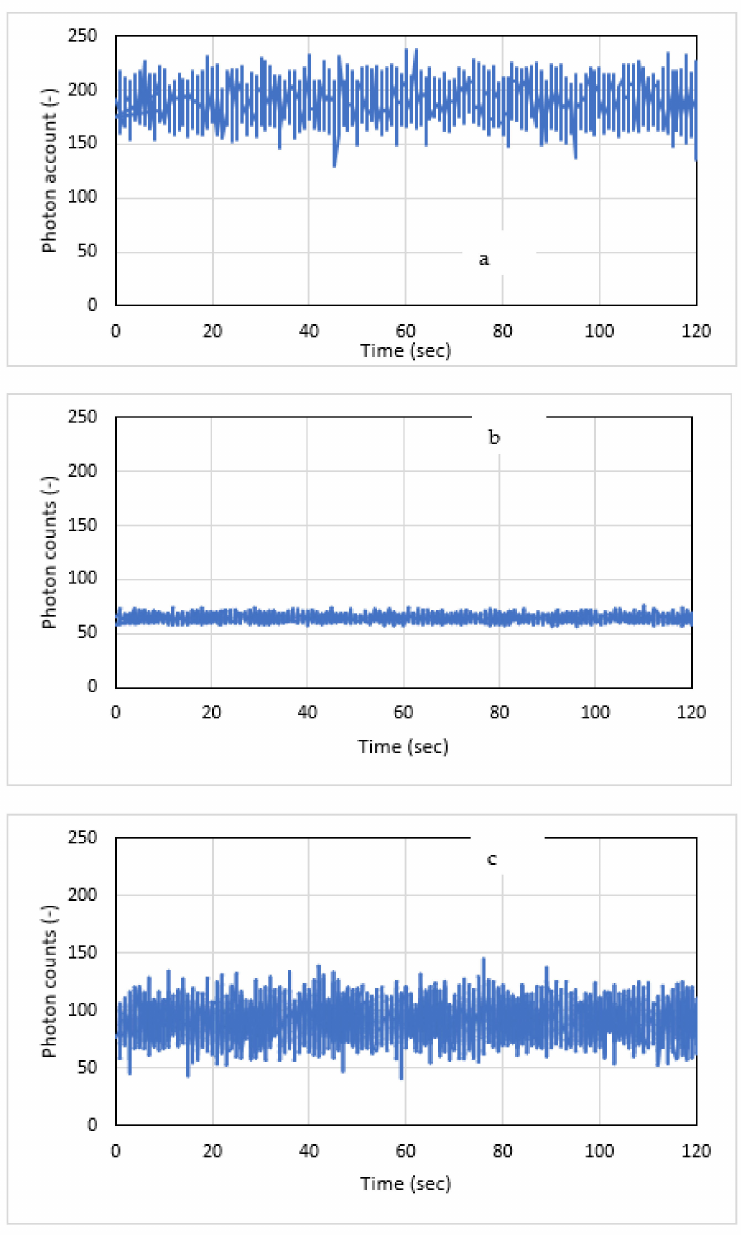
Figure 6. Fluctuations in photon count (Time-series) in a 12.7 cm diameter of split column in ( a ) empty column and ( b ) only water in column ( c ) air-water with gas velocities 3